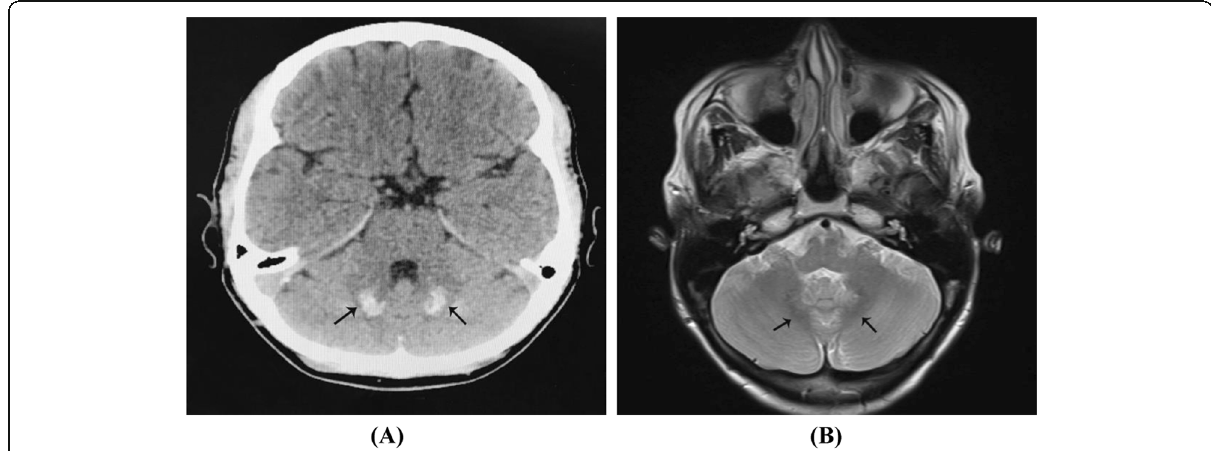
Fig. 1 Computed tomography (CT) scan ( a ) and magnetic resonance imaging (MRI) ( b )